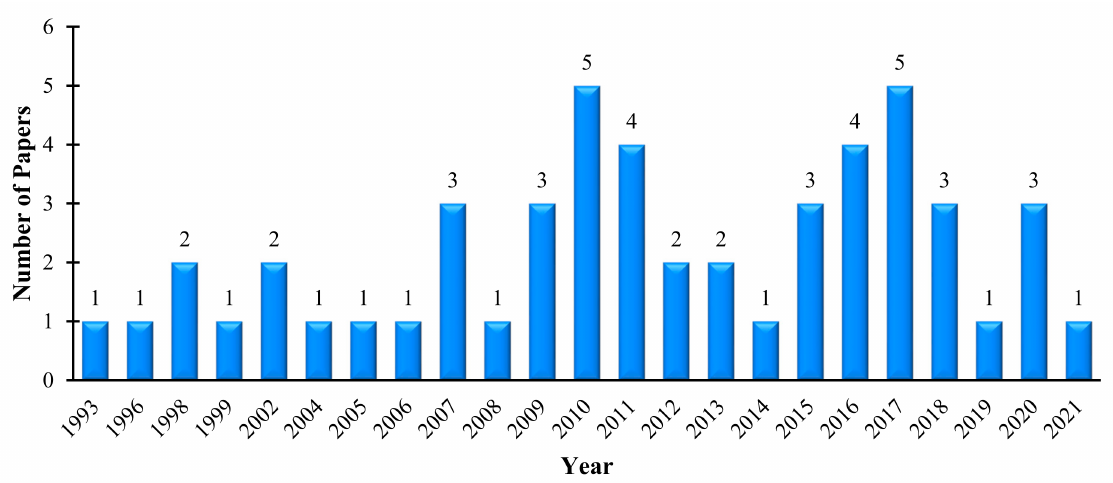
Figure 4. Trend of publications of machine learning techniques from 1993 to